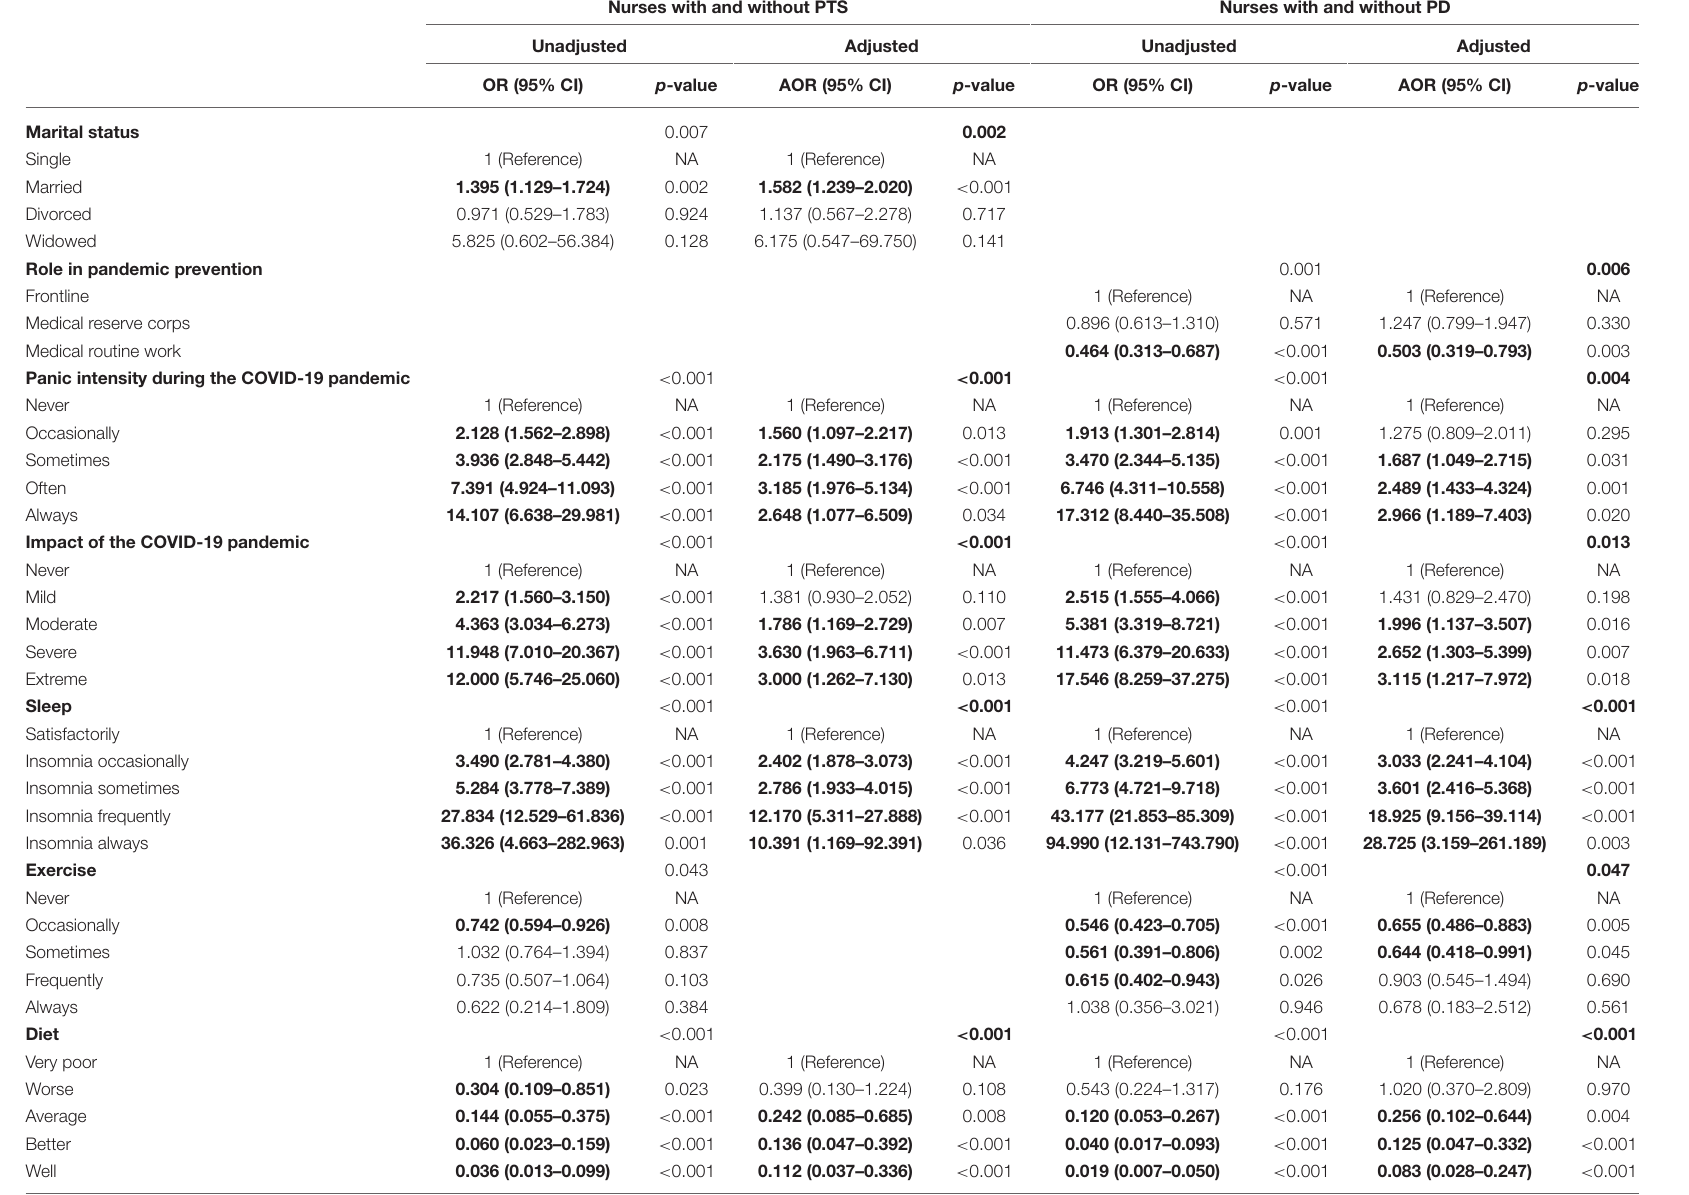
TABLE 2 | Logistic regression with variables predicting PTS and PD in medical staff (nurses). Nurses with and without PTS Nurses with and without